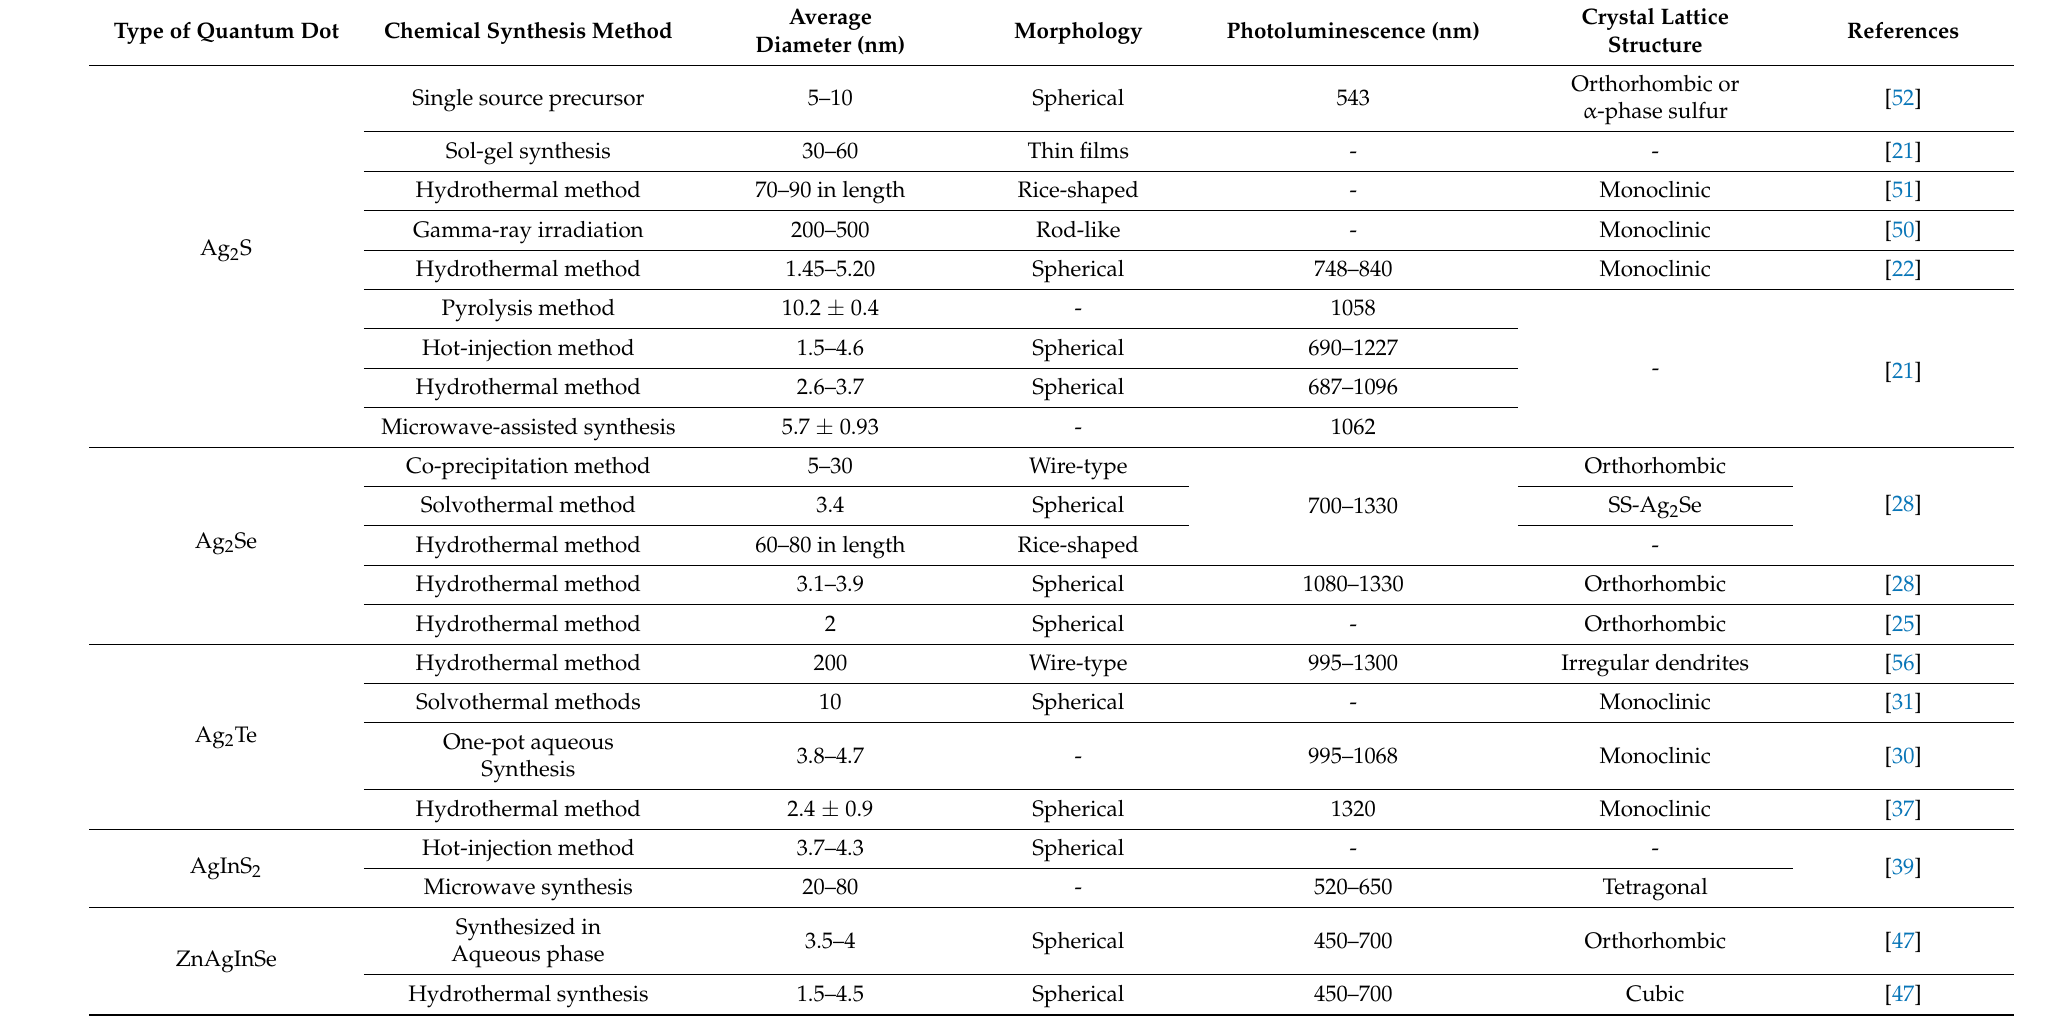
Table 2. Methods of chemical synthesis of Ag-based quantum dots and their